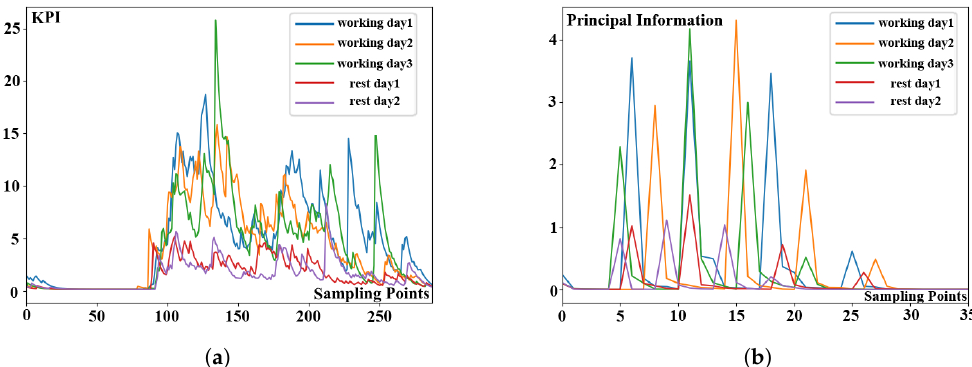
Figure 8. The comparison before and after information extraction. ( a ) Sub-sequences before extracting the principal information. ( b ) Sub-sequences after extracting the principal